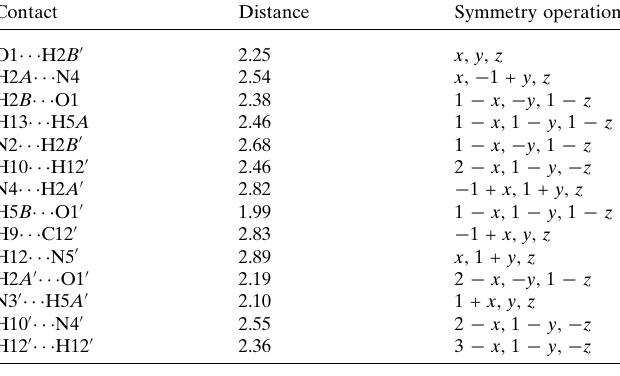
Table 6 Percentage contributions of interatomic contacts to the Hirshfeld surface for compound (II).